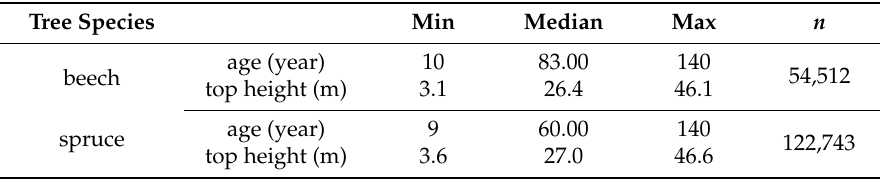
Table A4. Characteristics of height dataset used for fitting Equation